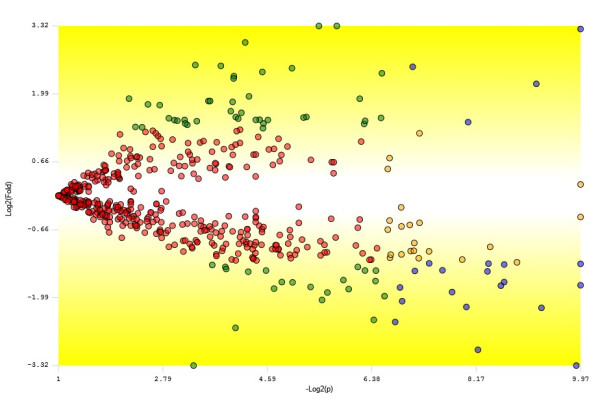
TFold pairwise analysis of proteins identified from ABE fermentation using glucose and xylose substrates. Each protein is represented as a dot and is mapped according to its log2 (fold change) on the ordinate axis and its -log2 (t-test p-value) on the abscissa axis. Refer to the text for the differentially expressed protein details